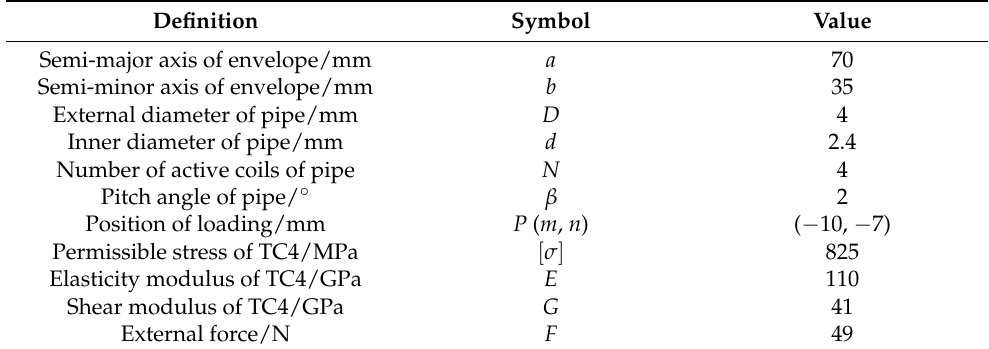
Table 4. Parameters of the numerical validation model of the elliptical-helical pipe with bias